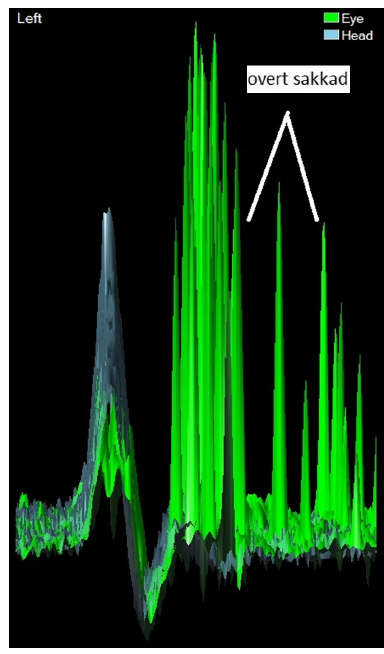
Figure 2. The 3D overt saccade image of the left lateral semicircular